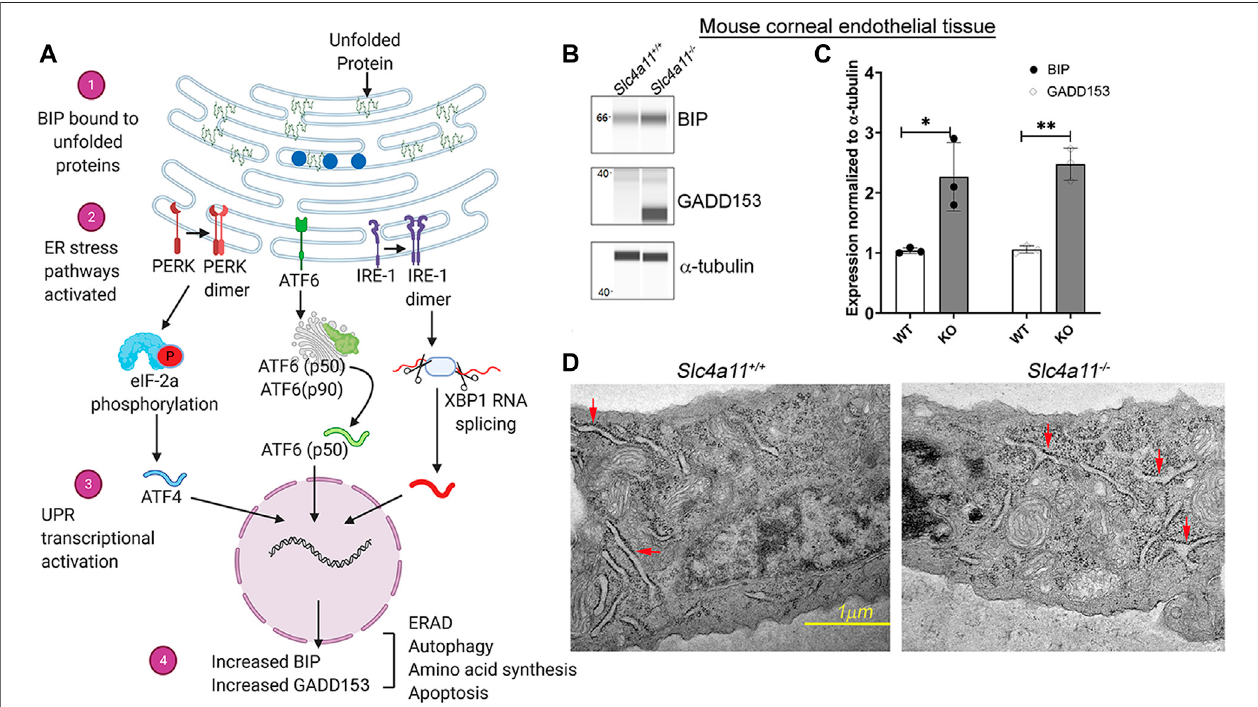
FIGURE1| TheERStressResponseinWTand KOMouseCornealEndothelium. (A) ERstressthroughtheunfoldedproteinresponsepathway ishighlyregulated throughthreemainsignalingpathways — ATF6,IRE1,andPERK.Inanormalcell,theproteinBIP(bluecircles)isassociatedwiththeabovementionedmolecules,thereby preventing the activation of ER stress associated signal transductions. With the accumulation of unfolded proteins the chaperone BIP associates with them (1) and less withthesignaling molecules thereby activating thesignaling pathways (2)and theERstressassociatedtranscriptionalmachinery(3).IncreasedGADD153 and BIP levels are considered tobe twoof themajor outcomes ofERstresspathways(4). (B) Wes immunoassayanalysisto determine the expression ofER stress markers, BIP and GADD153 in Slc4a11 WT and KO corneal endothelial tissue. (C) Quanti fi cation of Wes immunoblots from Panel (B) n = 3, ** p < 0.001 (D) Electron micrograph of Slc4a11 +/+ and Slc4a11 − / − corneal endothelial tissue. Red arrows point to the ER. Scale — 1 μ M.